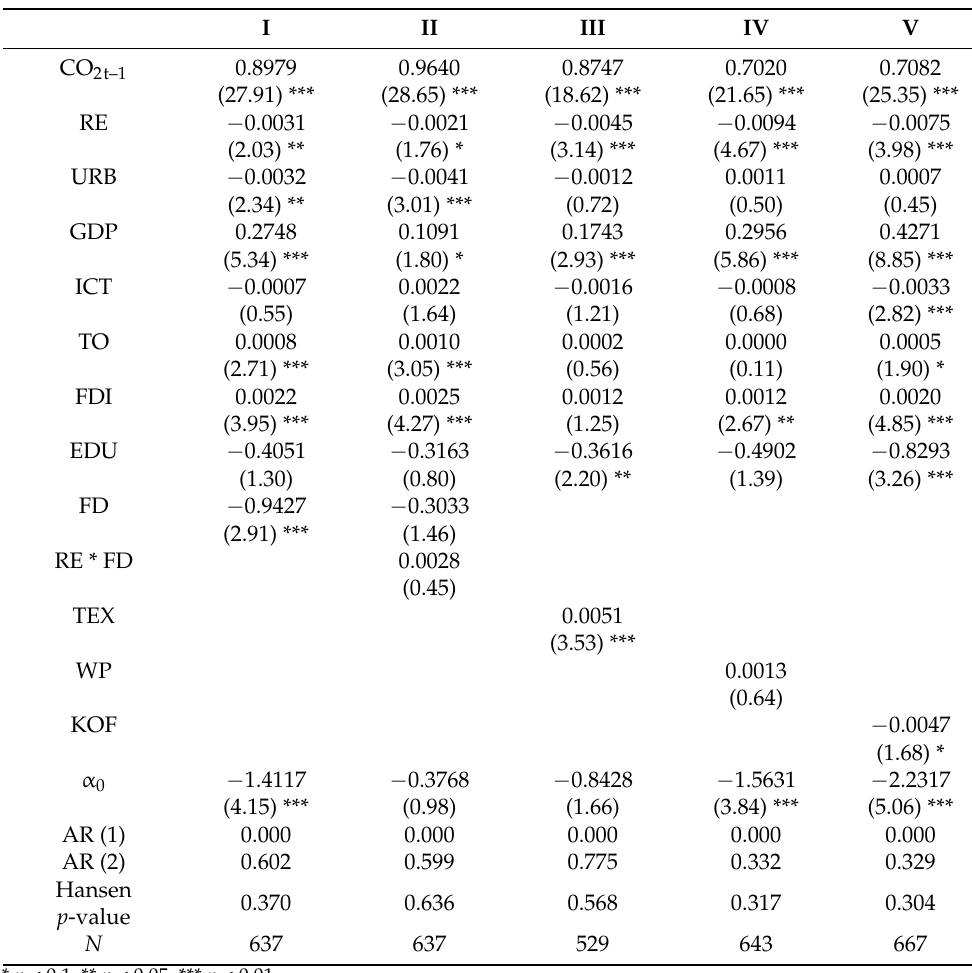
Table 4. CO 2 per capita: additional controls.